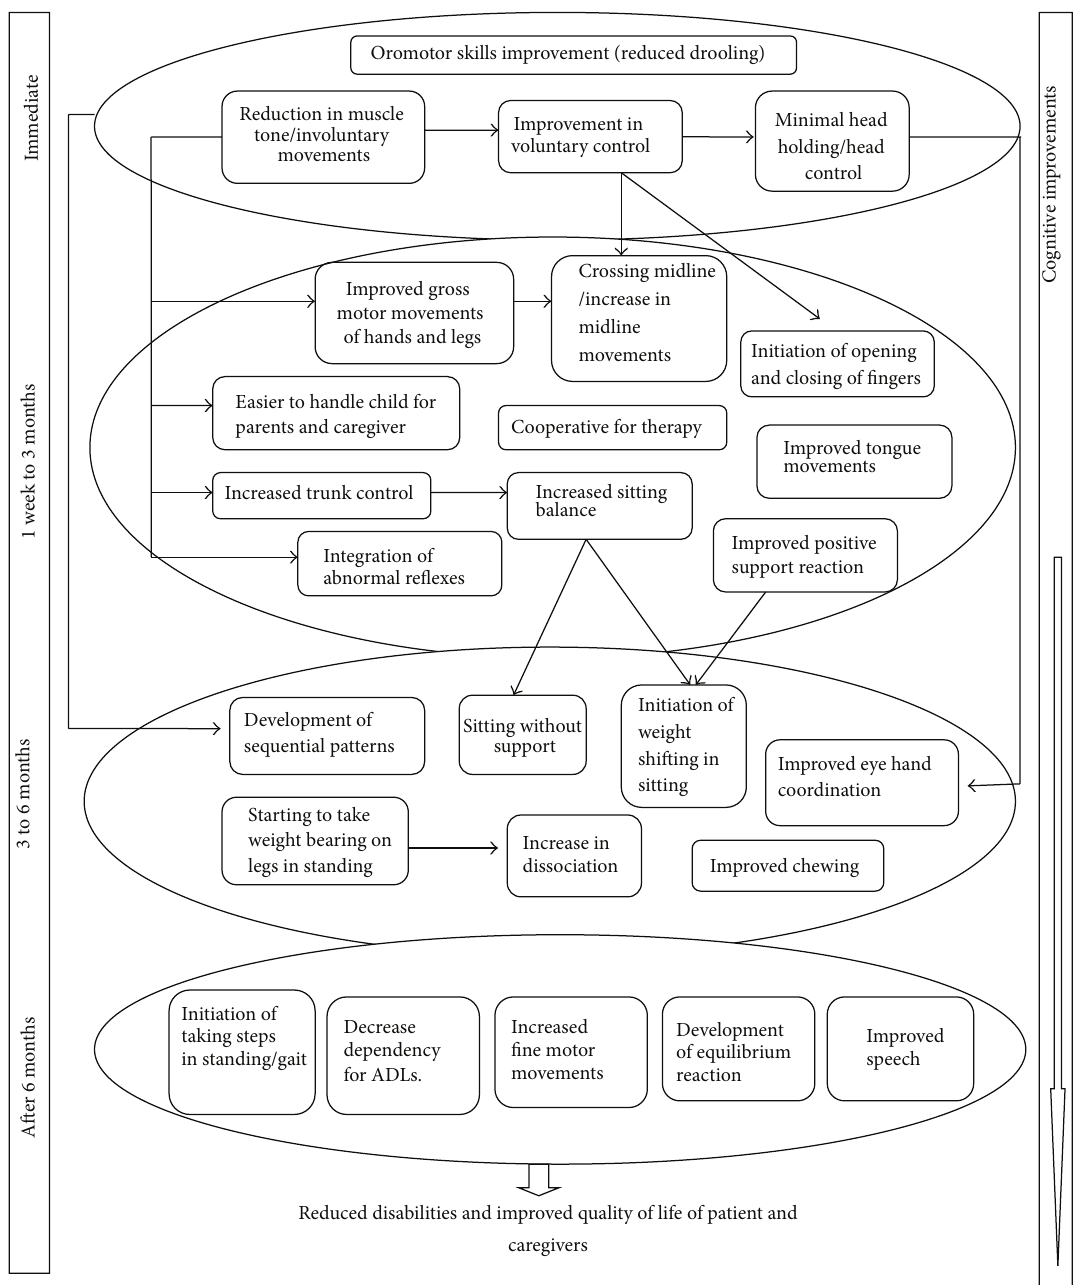
Figure 5: Flow chart depicting sequential developmental clinical improvements after autologous BMMNCs transplantation in cerebral palsy. On the left side, there are time periods within which the symptomatic improvements are seen. Each horizontal circle corresponds to the respective time period. The arrows signify direct causal effect between the symptomatic improvements. On the right side, the cognitive improvements are seen to be